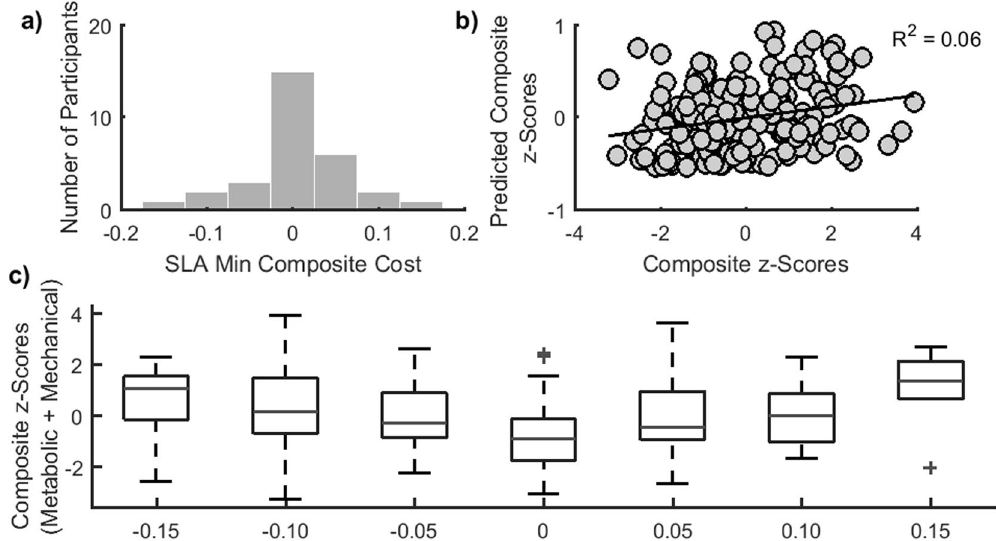
Figure 5. Associations between a composite estimate of energetic cost and asymmetry. ( a ) Histogram of step length asymmetries associated with the minimum composite cost. ( b ) Plot of measured vs. predicted composite costs defined in Equation 5. ( c ) Distributions of composite costs associated with each level of achieved asymmetry. These results match the hypothesized relationship presented in Fig.